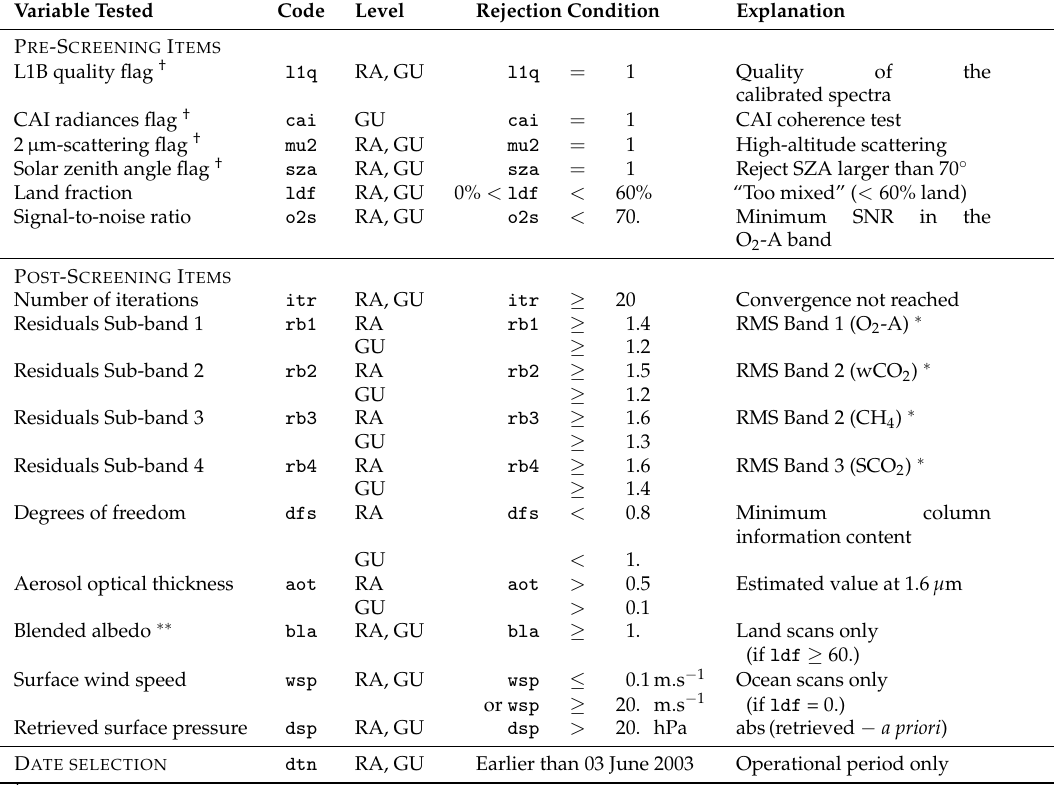
Table A1. Filtering criteria (pre- and post-processing) used for the TANSO-FTS products at NIES (Version 02.21). Some criteria have different thresholds for, or are specific to, different release levels: the “Research Announcement” (RA) and “General Users” (GU)